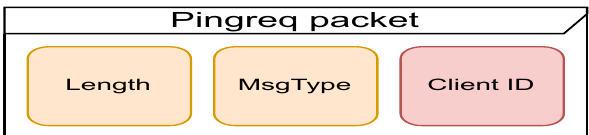
Figure 23. Pingreq packet format.